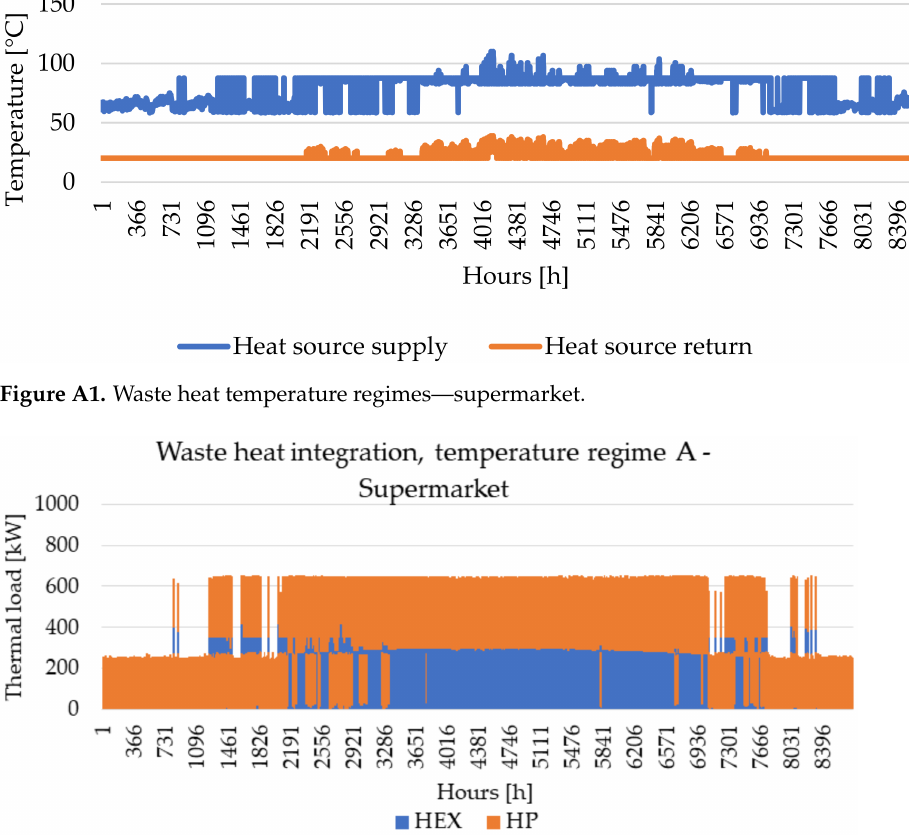
Figure A2. Waste heat utilization per technology, DH temperature regime